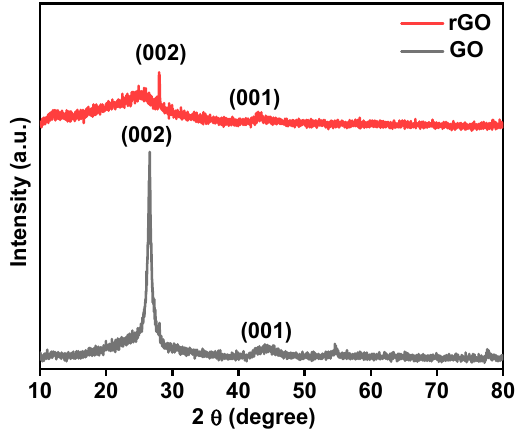
Figure 3. XRD patterns of GO and rGO.